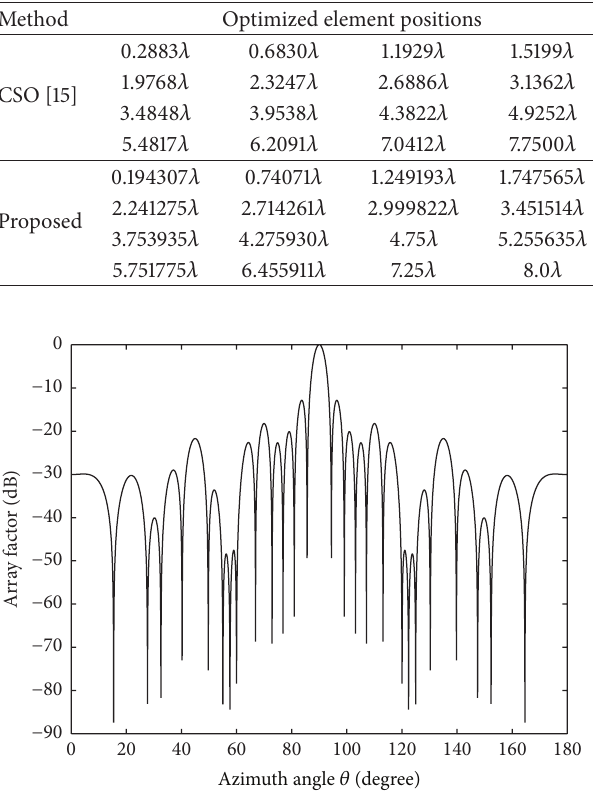
Figure 4: Array pattern for Example